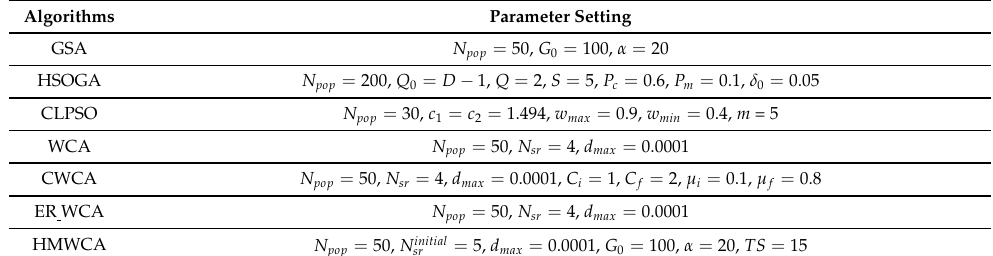
Table 3. Parameters setting.